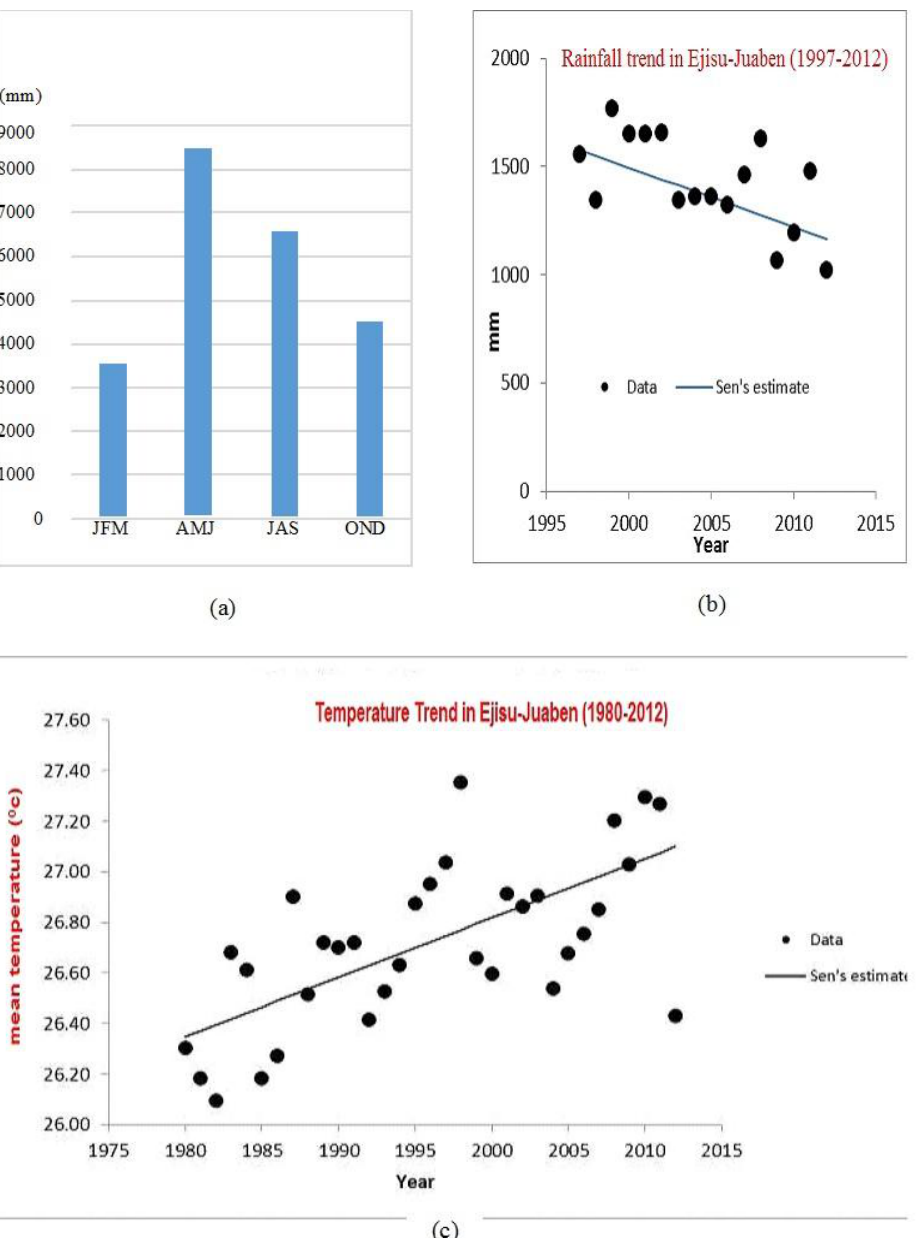
Fig. 2. Accumulated mean rainfall of Ejisu-Juaben Municipality (EJM) in mm (a); Rainfall trend in EJM from 1997-2012 (b); Temperature trend of EJM (1980-2012) (c) JFM= January, February, March AMJ= April, May, June JAS= July, August, September OND=October, November,